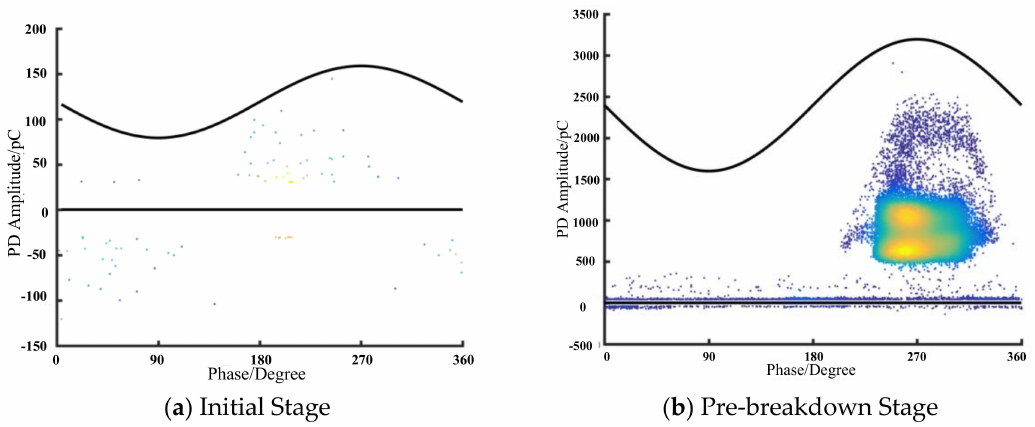
Figure 8. PRPD patterns under AC/DC proportion of